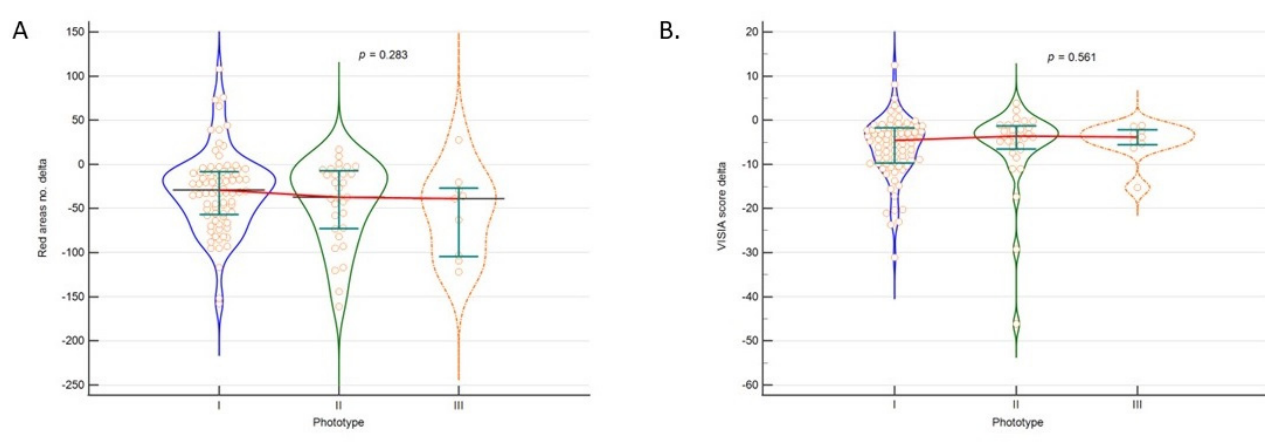
Figure 2. Treatment efficacy in regard to ( A ). Red area number and ( B ). VISI score regarding skin phototype.